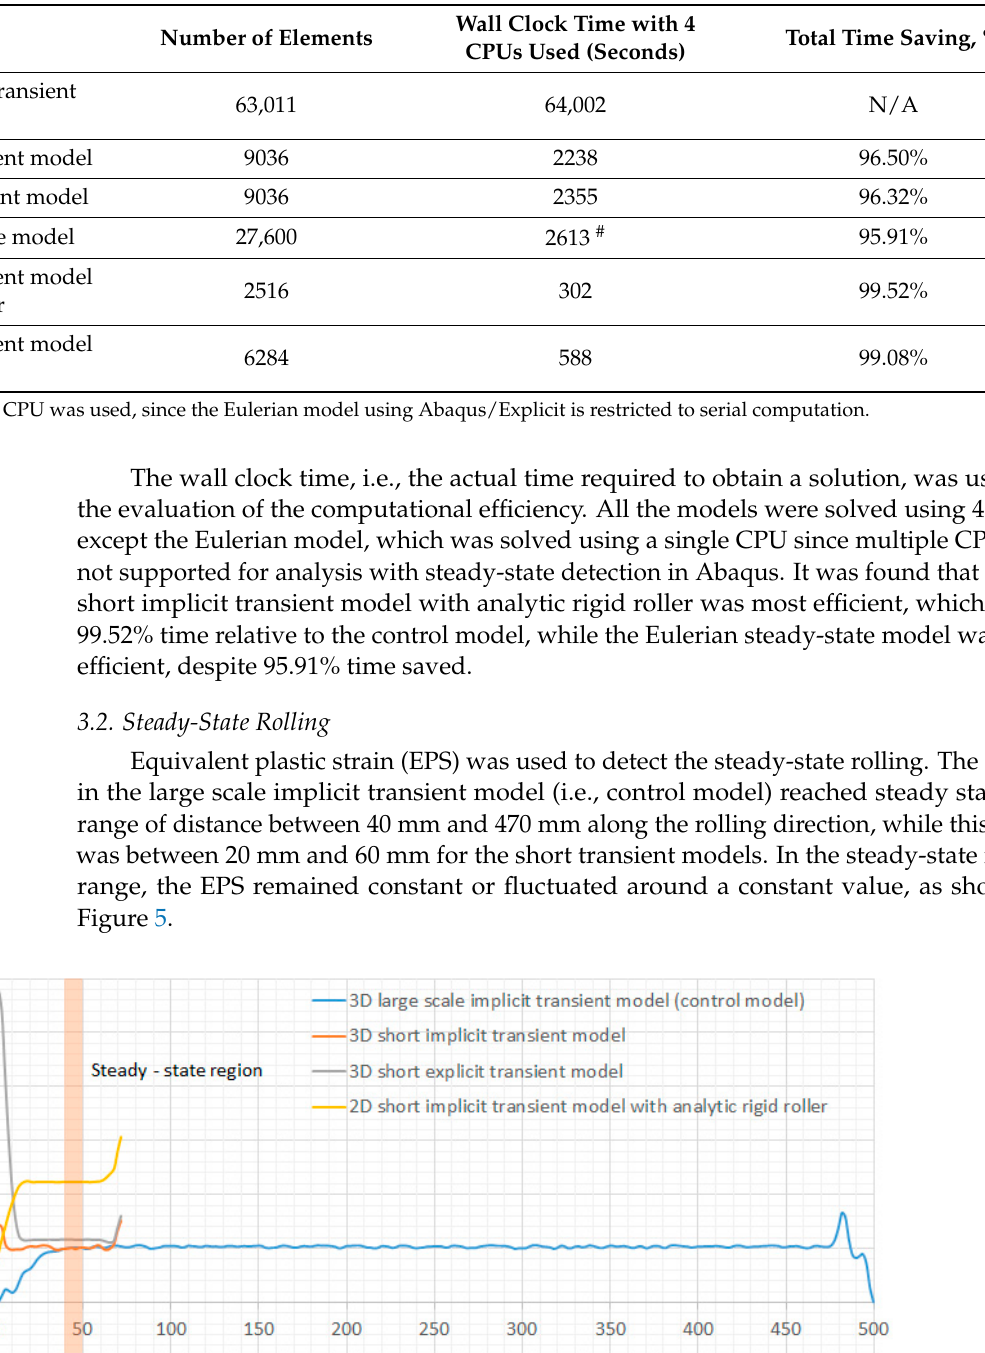
range from 40 mm to 50 mm. Based on the EPS distributions, the inspection plane of the short models was selected with a location at 48 mm from the rolling start position. The was equivalent to a rolling distance of 58